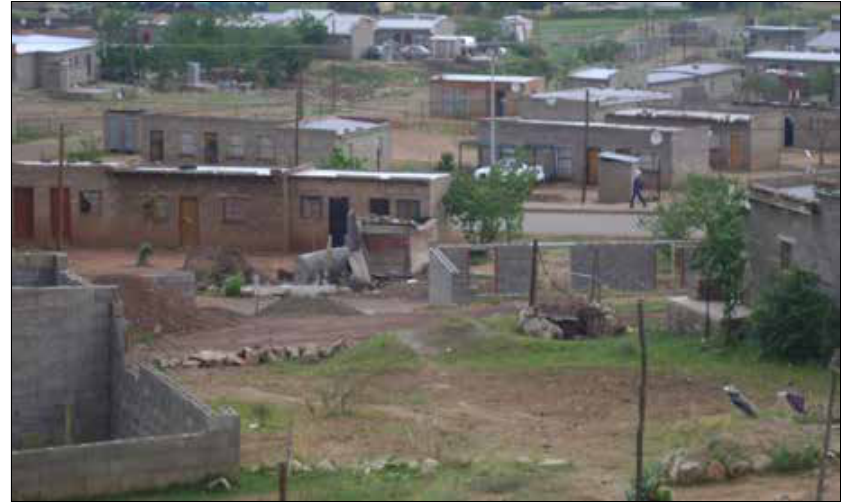
Figure 5: Unplanned, unregulated spatial development close to AGOA